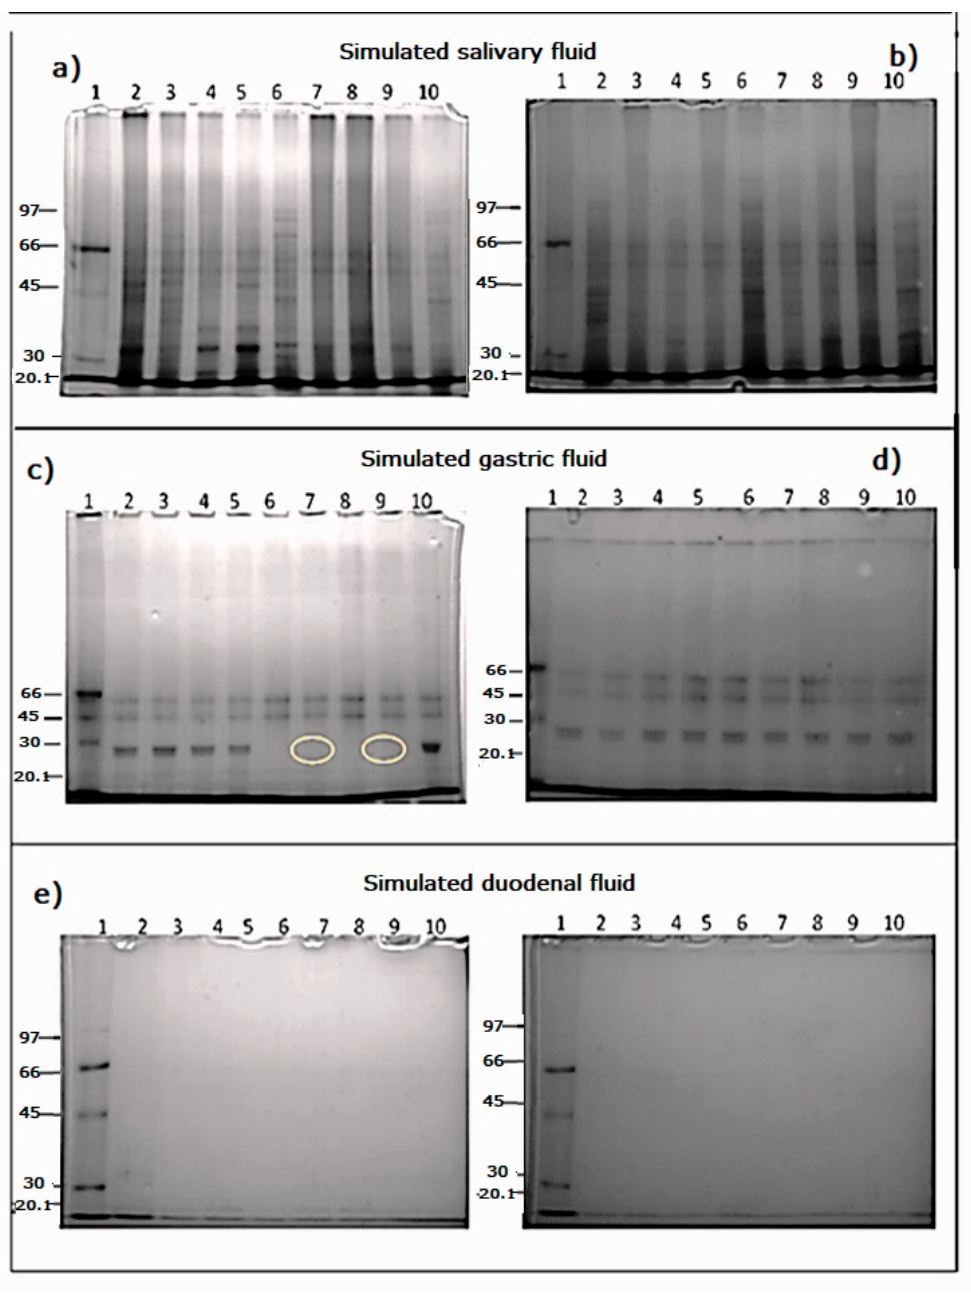
Figure 7. Hydrolysis of quinoa protein-chitosan edible films. ( a , c , e ): QW protein; lanes: 1, QW; 2, QW